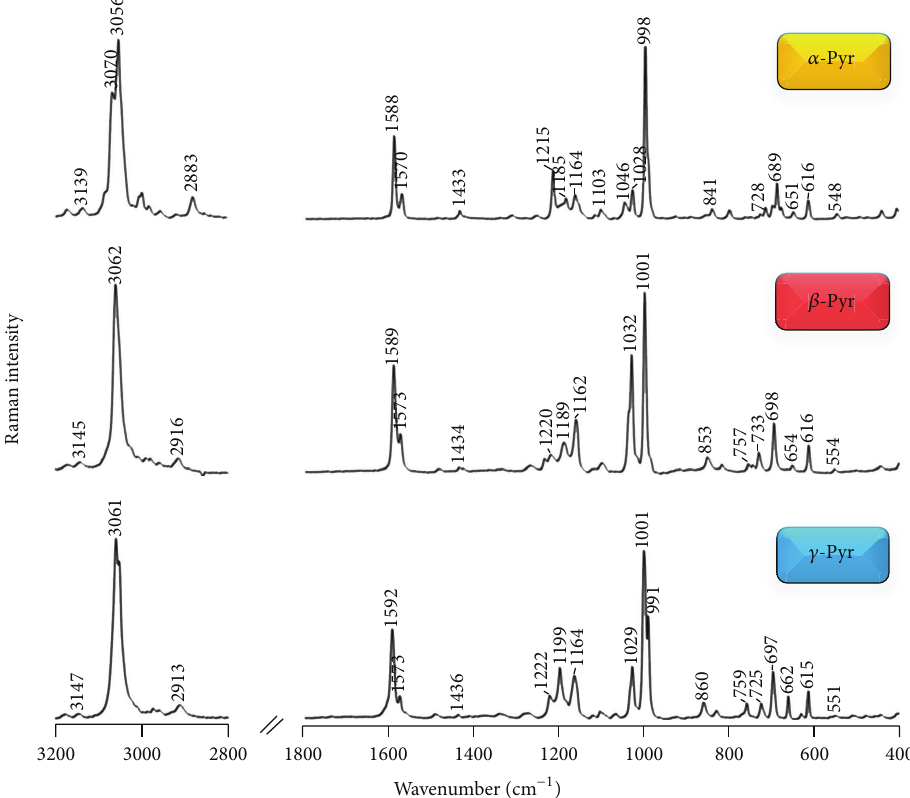
Figure 1: The FT-RS spectra of 𝛼 -Pyr, 𝛽 -Pyr, and 𝛾 -Pyr in the spectral ranges of 3200–2800 and 1800–400 cm −1 .